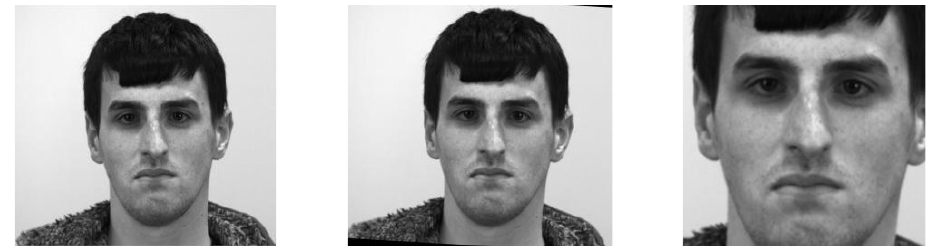
Figure 3. Face alignment and cropping. From left to right: original image, face aligned image, cropped image.